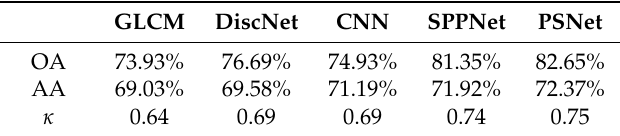
Figure 17. Classification map overlaid with ground truth for the Guangdong data (using 10% of data for training). Three regions are highlighted in ( a ) for the convenience of comparison. The unidentifiable class is shown in black. Table 7. Classification performance comparison on Guangdong data using overall accuracy (OA), average accuracy (AA) and Kappa coefficient ( κ